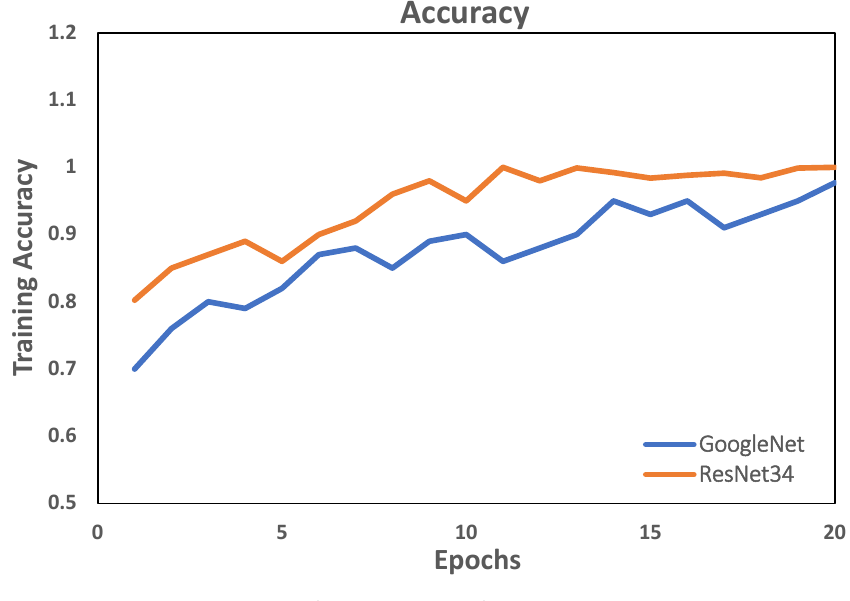
Figure 5. Training accuracy with respect to epochs.